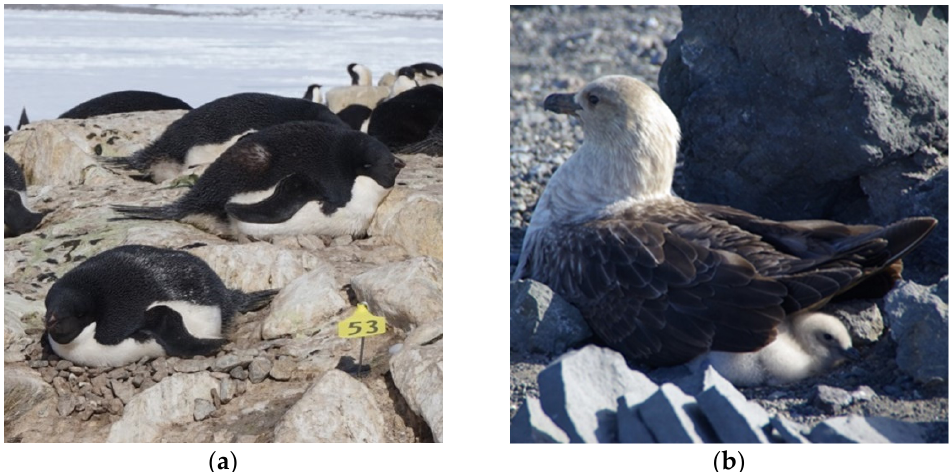
Figure 3. Monitoring of penguin and skua nests: ( a ) an Adélie penguin nest marked at Adélie Cove and ( b ) a skua nesting around subcolonies marked with GPS at Edmonson Point (photo silviaol- mastroni@PNRA2017).